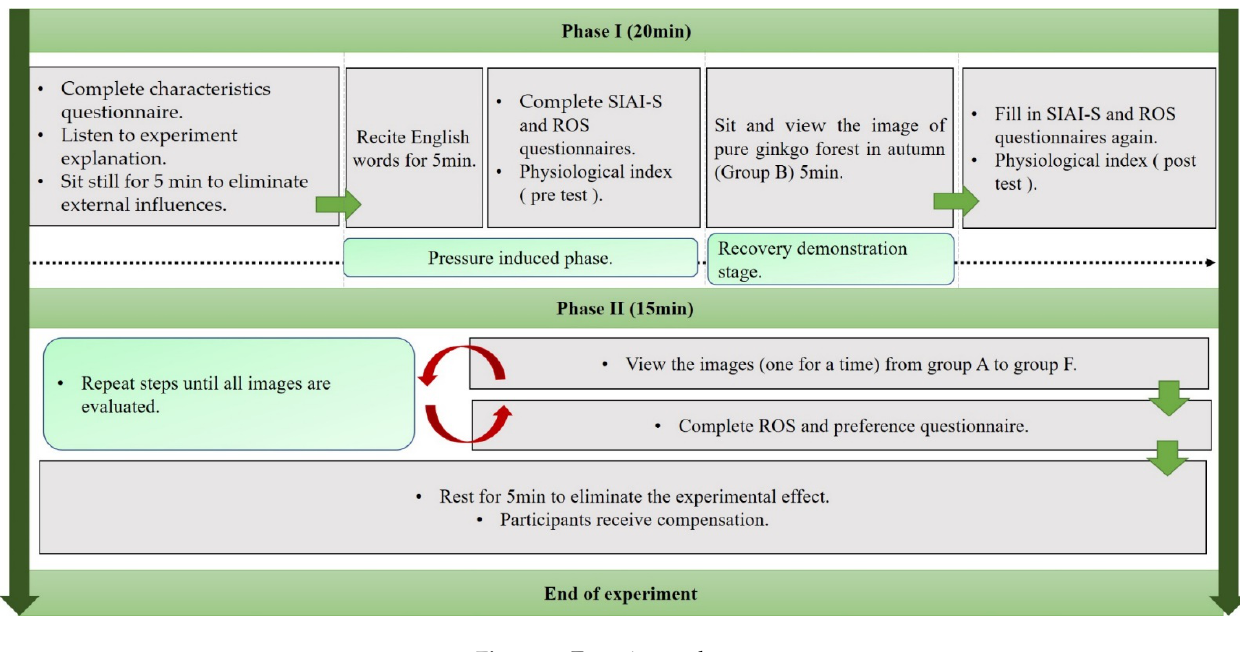
Figure 2. Experimental steps .